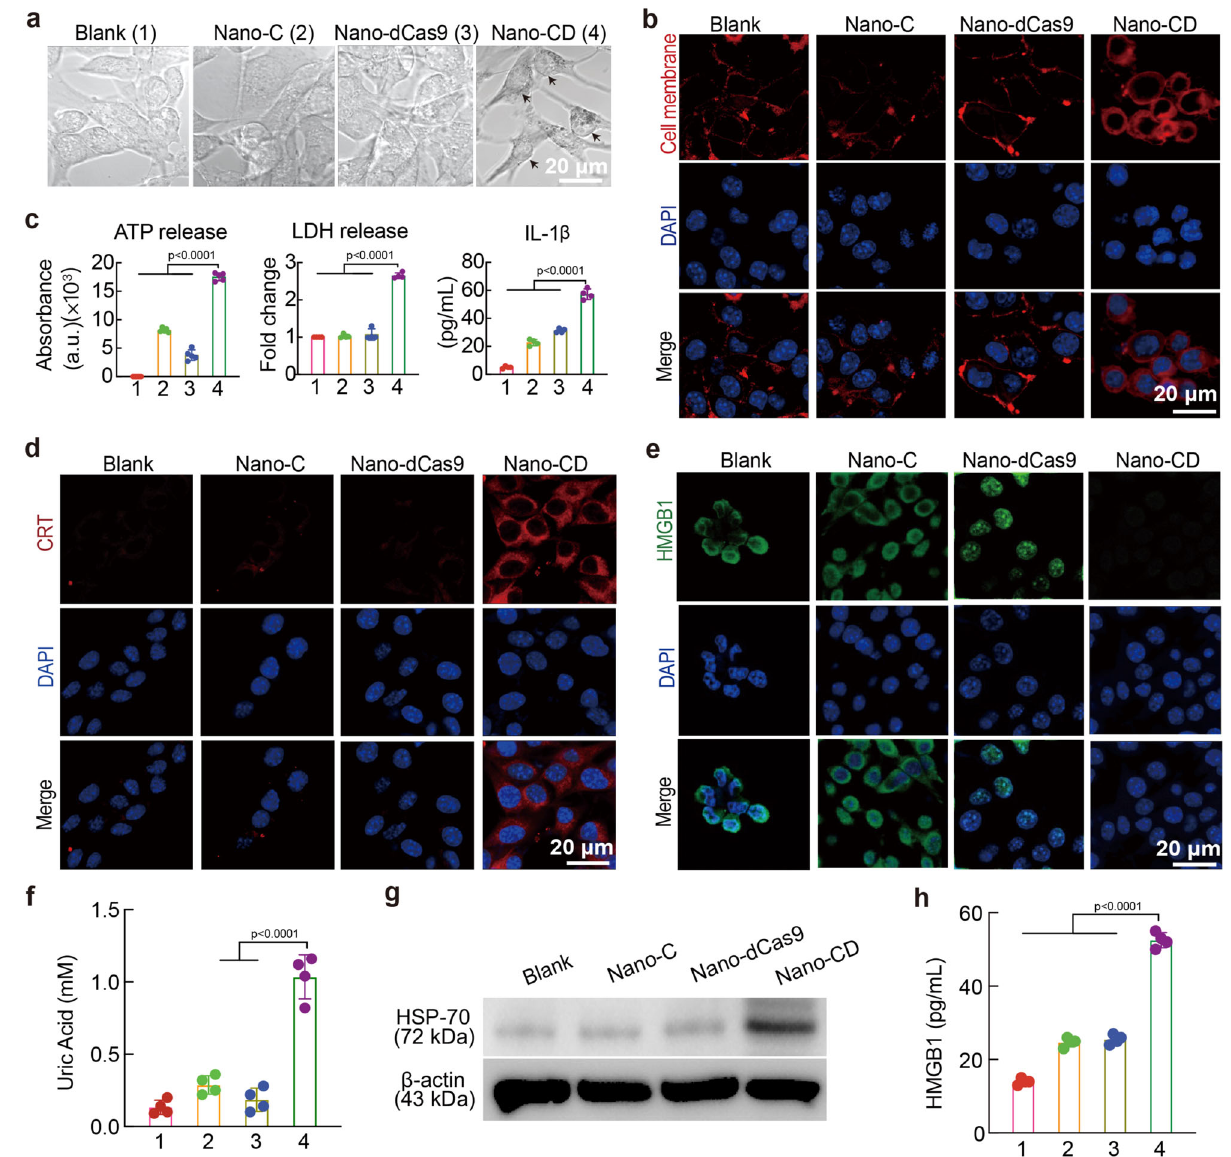
Fig. 3 | Representative characterization of pyroptosis. a The morphological images of pyroptosis by CLSM (Scale bar: 10 μ m). b Observation of ruptured cell membrane by CLSM (cell membrane: red; Nucleus: blue, Scale bar: 20 μ m). c The extracellular secretion of ATP, LDH and IL-1 β . d CRT expression analysis by CLSM ( n =4 biological replicates per group). e CLSMobservedthe eliminationof HMGB1 in B16F10 cells (Scale bar: 20 μ m). f Quantitive examination of uric acid